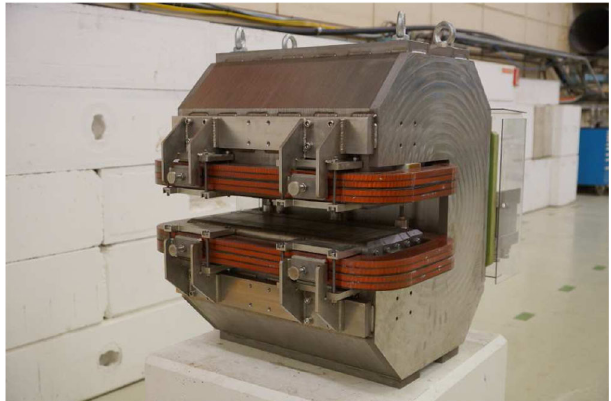
FIG. 6. Picture of prototype. Two geometrically identical prototype magnets have been built, one with a diluted and one with a nondiluted yoke.